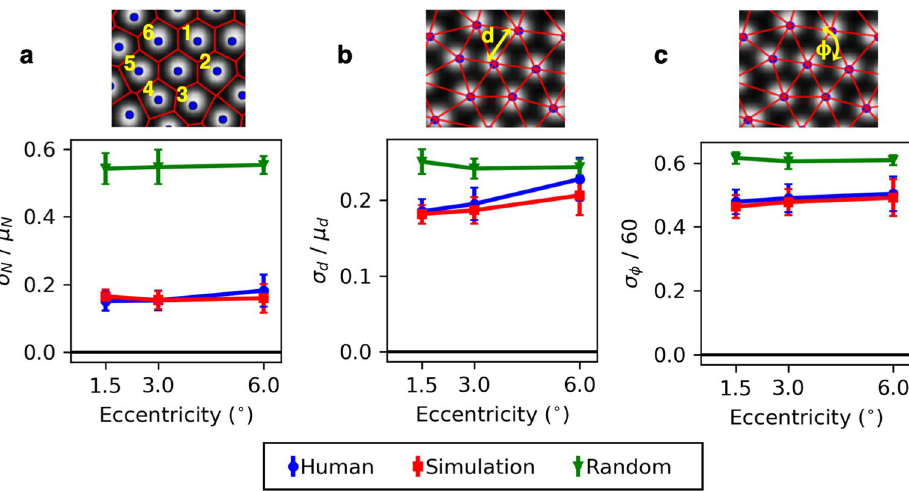
Figure 7. Three metrics of packing regularity (eccentricities the same as in Fig. 6) are compared for human- derived images and for synthetic images generated either using reaction-diffusion modelling or by randomly placing cells (i.e completely irregular packing with the same number of cones). For each metric the standard deviation is used as a measure of variability, normalised by the mean. A value of zero is equivalent to a completely regular mosaic. Each data point represents the mean, and each error bar the standard deviation, calculated over 27 human or 12 synthetic images. Images were manually labeled by five experienced markers and the data plotted here represent the average across markers. The panels show the variability in ( a ) the number of nearest neighbours, ( b ) the nearest neighbour distance and ( c ) the vertex angle between nearest